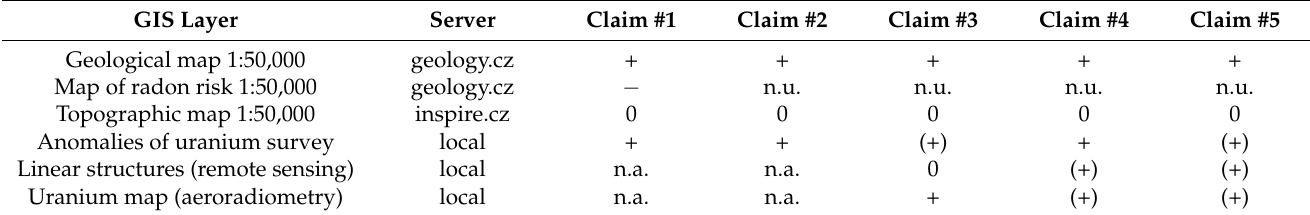
Table 3. Applicability of layers to search for sources of radioactive mineral springs in Claims #1–5. The code indicates the subjective contribution of the data layer for the localization of positive